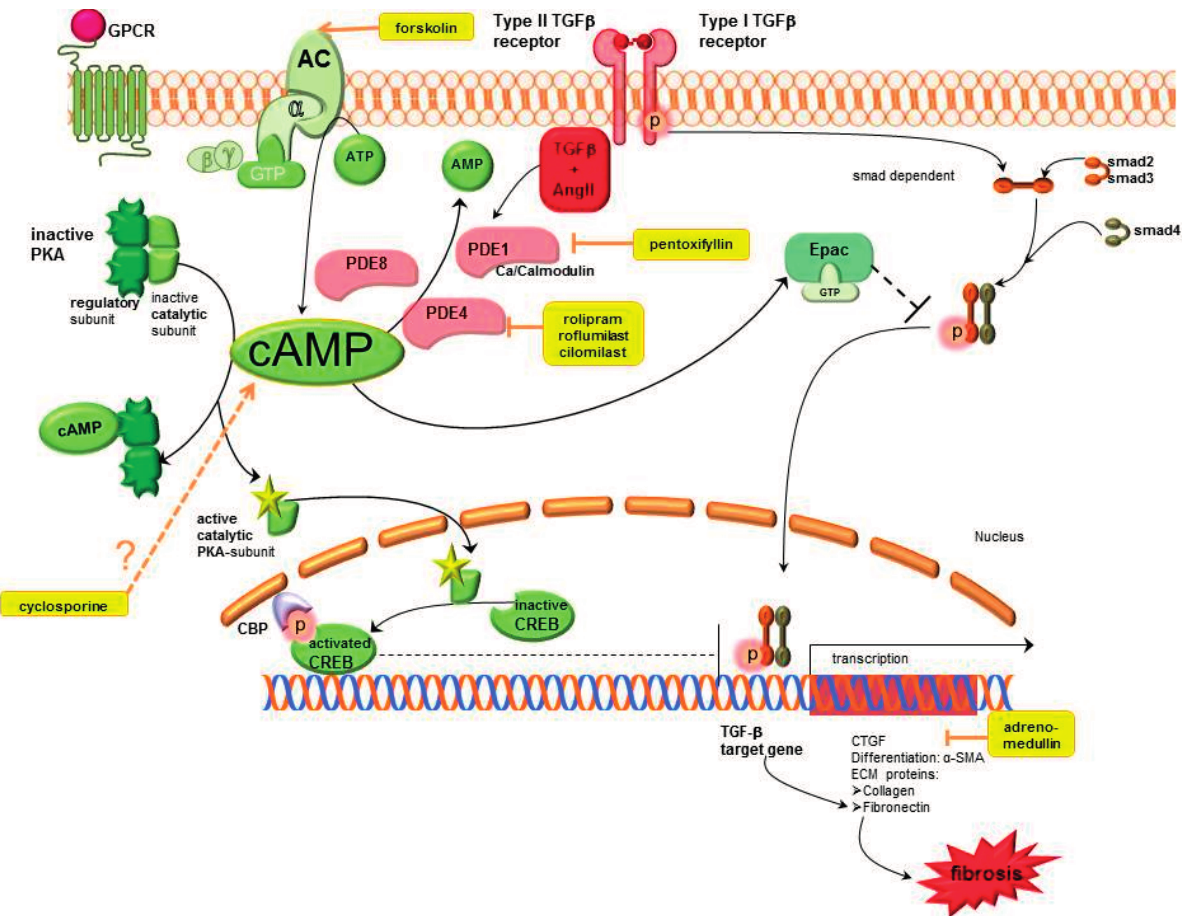
Figure 1. Cyclic adenosine monophosphate signalling pathways in kidney fibrosis including pharmacological treatment options. AC, adenylyl cyclase; AMP, adenosine monophosphate; ATP, adenosine triphosphate; cAMP, cyclic adenosine monophosphate; CBP, CREB binding protein; CREB, cAMP response element binding protein; CTGF, connective tissue growth factor; ECM, extracellular matrix; Epac, exchange protein directly activated by cAMP; GPCR, G protein coupled receptor; GTP, guanosine triphosphate; PDE, phosphodiesterase; PKA, protein kinase A; SMA, smooth muscle actin; smad, small mothers against decapentaplegic protein, TGF β , transforming growth factor β . cAMP exerts antifibrotic effects in fibrosis, which are mediated by stimulation of PKA and activated CREB that thus blocks TGF β mediated gene transcription. Furthermore, it activates Epac which blocks TGF β mediated smad dependent gene transcription. Therapeutic options which enhance cAMP are AC stimulators, PDE inhibitors, cyclosporine and adrenomedullin (shown in yellow). Motifolio PPT Drawing Toolkit was used for designing the